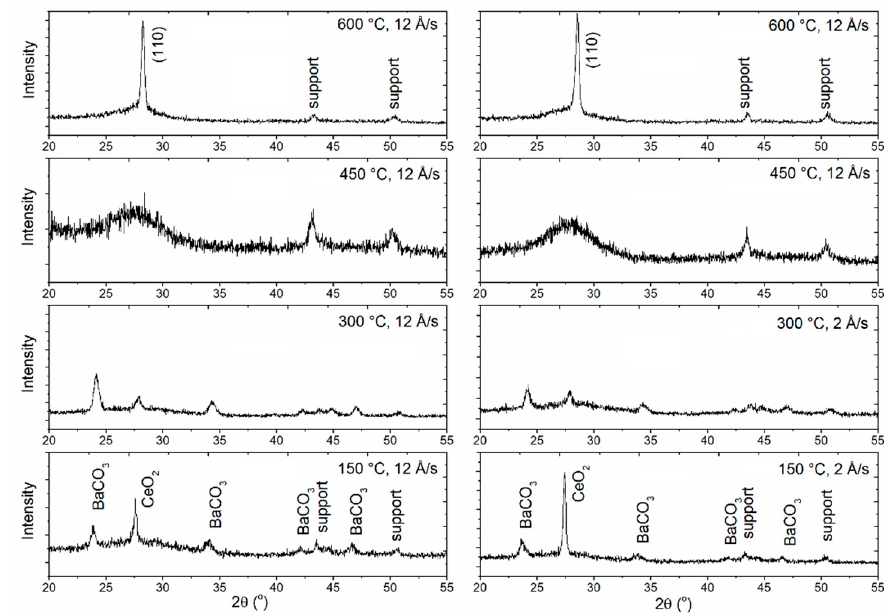
Figure 5. X-ray diffraction patterns of the films deposited on the stainless steel support using 2 Å/s and 12 Å/s deposition rates and different support temperatures. Miller indices of the (110) plane denote the main reflection of the barium cerate perovskite.